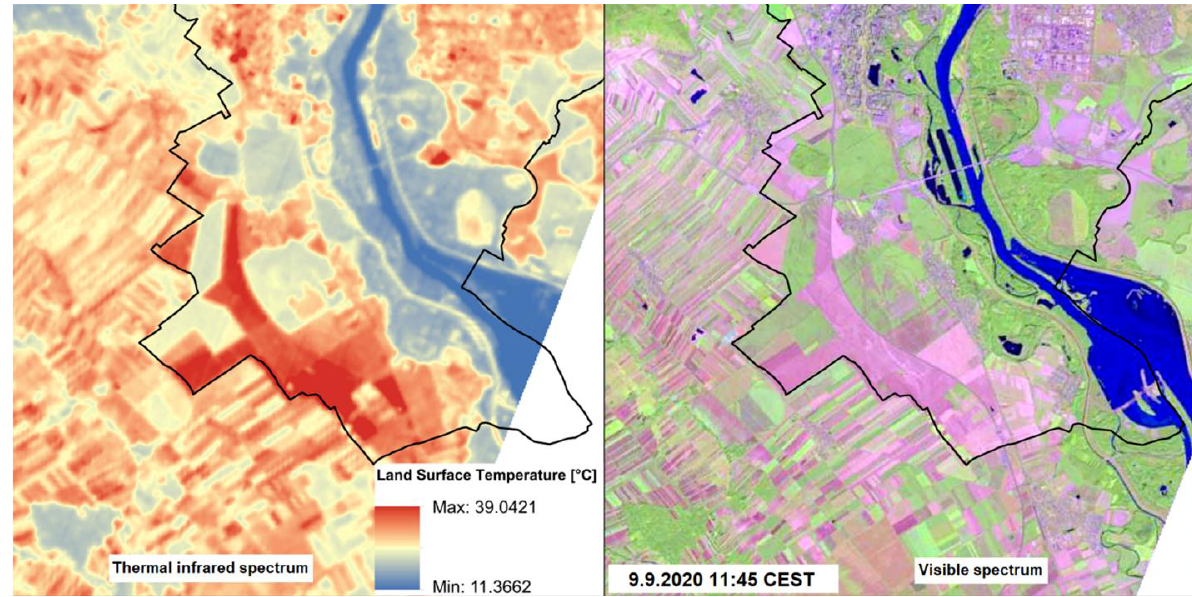
Figure 8. Surface temperatures in the area of Sysľovské polia (after the harvest) on the satellite pictures, 9 September 2021, about 11:45CEST (on the left: thermal infrared spectrum, on the right: Visible spectrum) (Landsat-8 image courtesy of the U.S. Geological Survey).